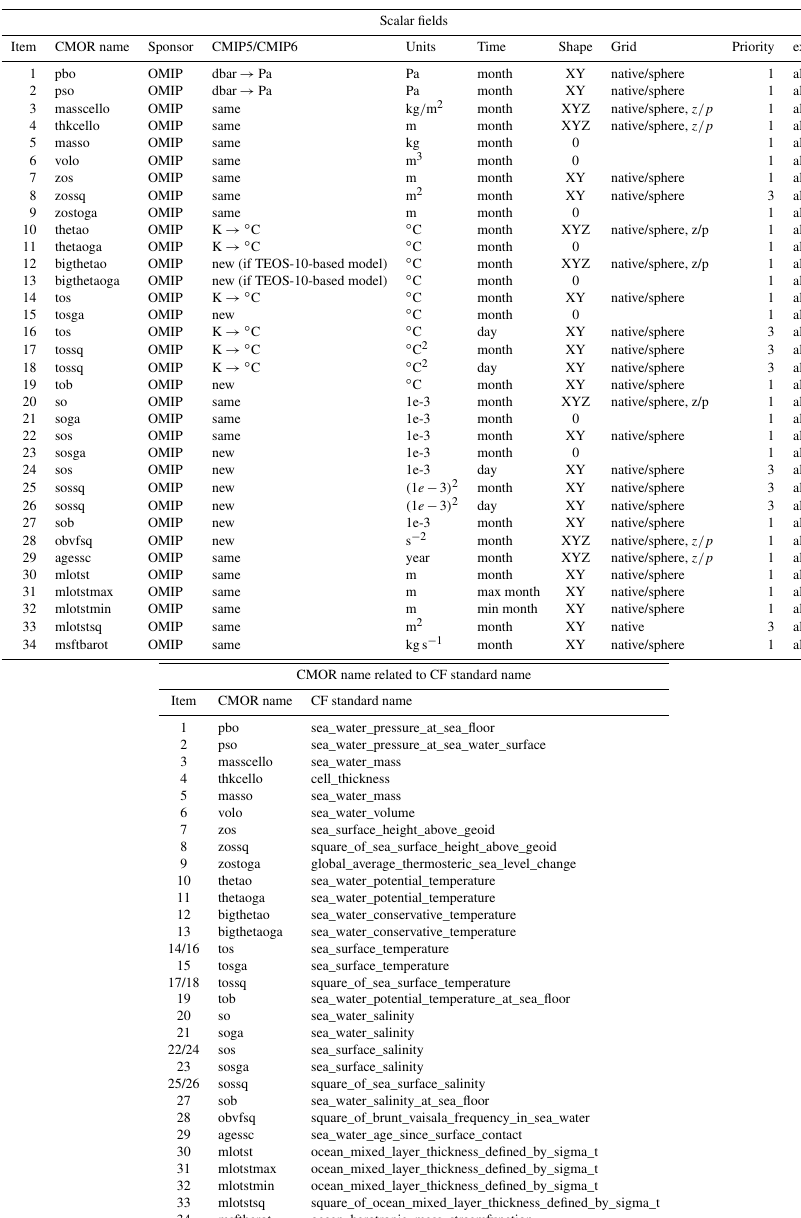
Table H1. Scalar fields to be saved from the ocean component in CMIP6 ocean model simulations. Entries with grids denoted “native/sphere” denote diagnostics where native and spherical output are recommended to facilitate analysis (see discussion in Sect. A3). The column in- dicating the experiment for saving the diagnostics generally says “all”, in which case we recommend the diagnostic be saved for CMIP6 experiments in which there is an ocean model component, including the DECK, historical simulations, FAFMIP, DAMIP, DCPP, Scenari- oMIP, and C4MIP, as well as the ocean/sea-ice OMIP simulations. The Priority = 1 diagnostics should be saved as decadal time means at decadal intervals for the piControl spin-up. Blank entries signal a characteristic that is not applicable for this particular diagnostic. Squared diagnostics are computed online by accumulating each time step, so that they can be useful for computing variance fields. The entry for masscello applies for models with time-dependent cell masses (Appendix B). For Boussinesq models with static grid cell volumes, the entry in Table G1 applies instead. The variables bigthetao and bigthetaoga are requested only for models enacting the TEOS-10 Conservative Temperature field as a prognostic model variable (see Sect. H12 and Appendix D). The lower sub-table lists the CMOR names and their corresponding CF standard